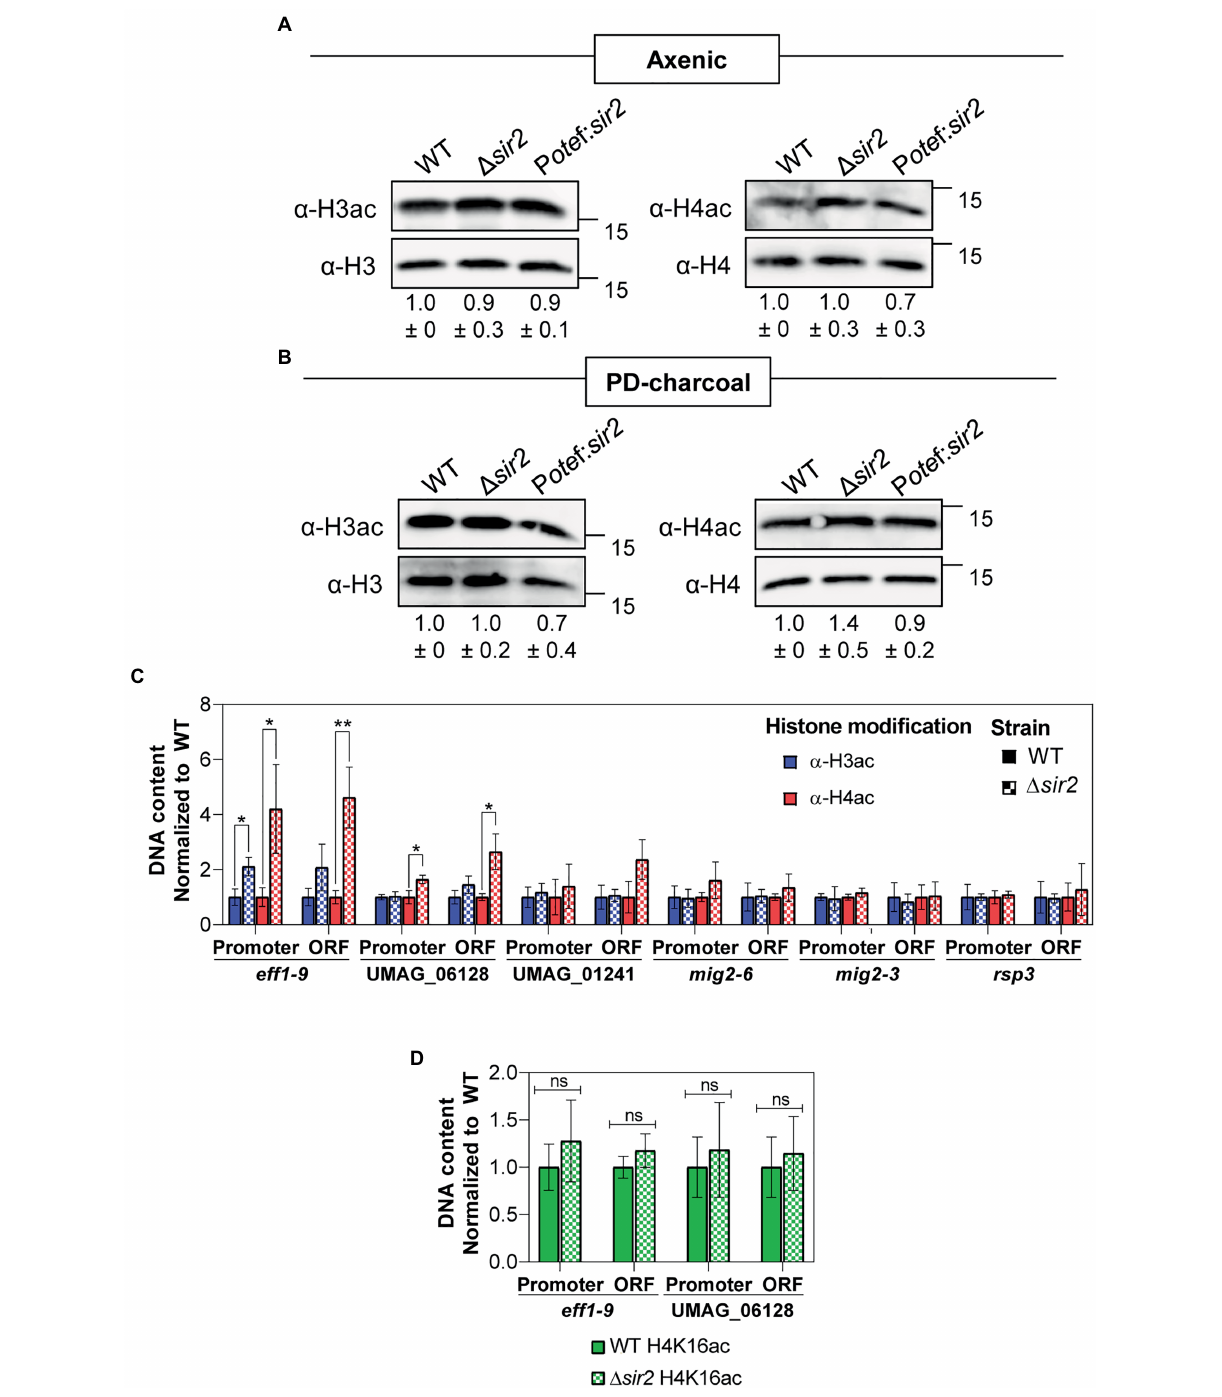
FIGURE 6 Effect of sir2 mutants in histone acetylation. (A,B) Total proteins extracted from axenic culture (A) or PD-charcoal plates (B) of wild-type, Δ sir2 and the P otef : sir2 > 1c strains were used for Western blotting. The H3ac and H4ac antibodies were used to detect histone acetylation and H3 and H4 antibodies were used as loading controls. H3ac and H4ac signals were normalized to H3 and H4 levels, respectively, and compared to wild-type from three independent replicates. (C,D) ChIP analysis using H3ac and H4ac antibodies (C) or H4K16ac antibody (D) on chromatin extracts from axenic culture of wild-type and Δ sir2 strains. Immunoprecipitated DNA was analyzed by RT-qPCR, amplifying regions within the promoter and the open reading frame (ORF) of the indicated gene. Values correspond to the amount of DNA recovered in the IP relative to ppi1 gene. Values were normalized to wild-type. Error bars represent the standard deviation from at least three independent replicates. Student’s t-test statistical analysis was performed (ns, no significant, * p -value < 0.05, ** p -value <